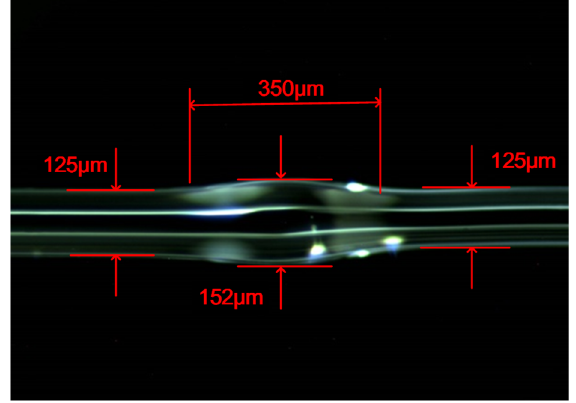
Figure 2. The optical fiber waist-enlarged bitaper under microscope.